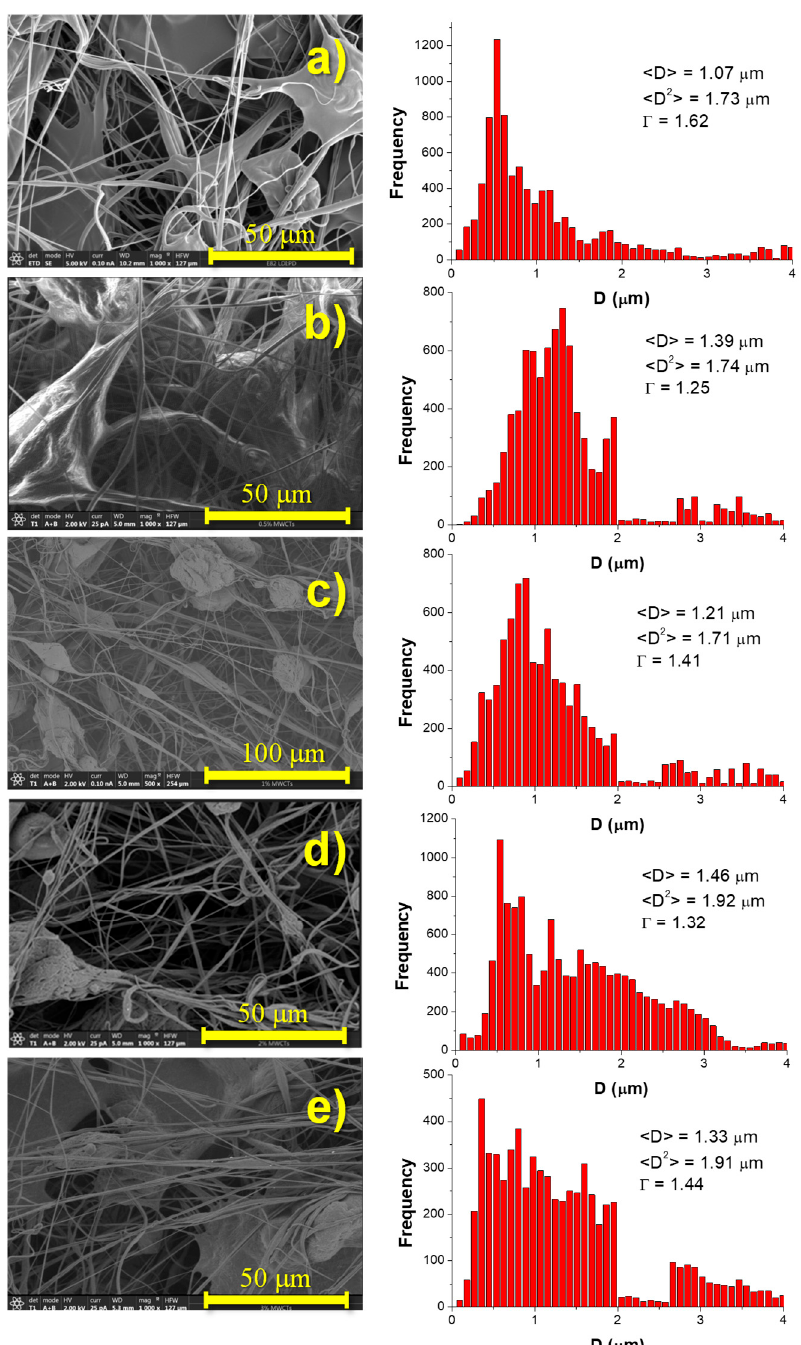
Figure 3. SEM images, diameter distributions, values of average diameter ( <D>) , second moment of of the distribution (< D 2 >), and dispersion of diameters ( Γ ) of the materials under study: ( a ) 0.0%; the distribution ( <D 2 > ), and dispersion of diameters ( Γ ) of the materials under study: ( a ) 0.0%; ( b ) ( b ) 0.5%; ( c ) 1.0%; ( d ) 2.0%; ( e ) 3.0% 0.5%; ( c ) 1.0%; ( d ) 2.0%; ( e ) 3.0% MWCNT.